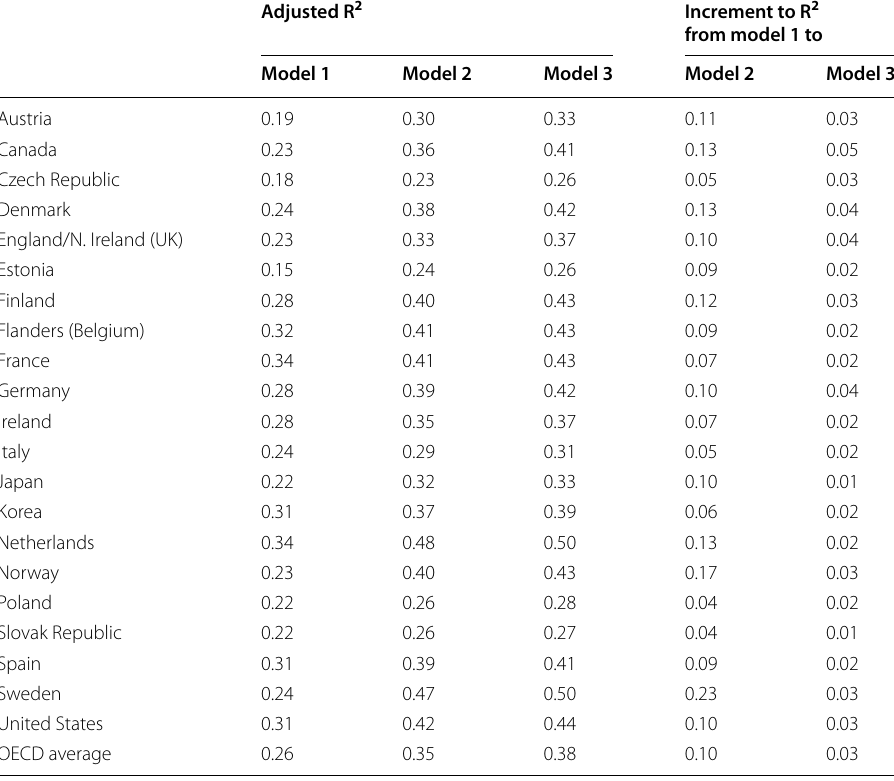
Table 2 Explained variance (adjusted R 2 ) for three models. Source: Programme for the International Assessment of Adult Competencies